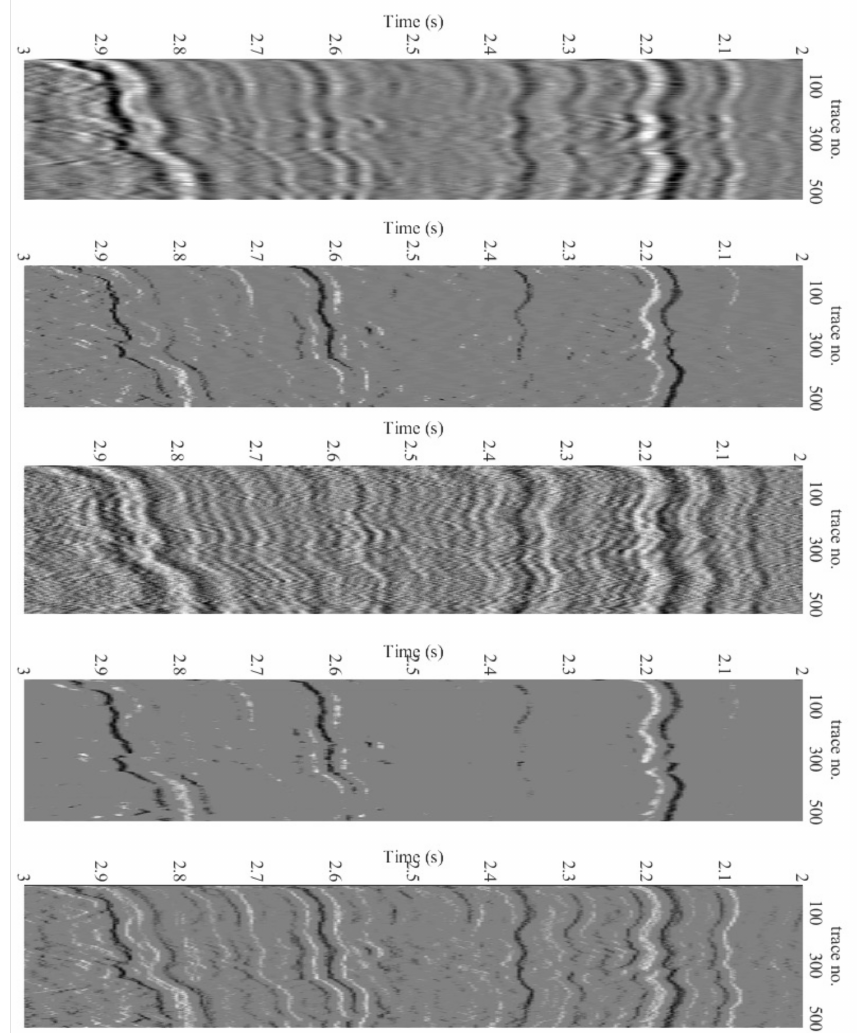
Figure 12. Deconvolution results. Top to bottom: Subset of received data for 2 ≤ t ≤ 3s and 500 traces, BP method, SP method, Proposed (first iteration) and Proposed (last iteration).